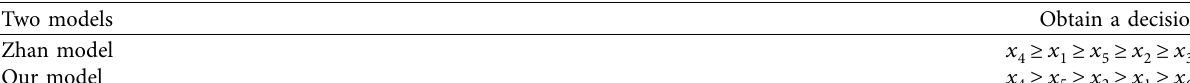
Table 24: Table for the ranking results for Case 2.